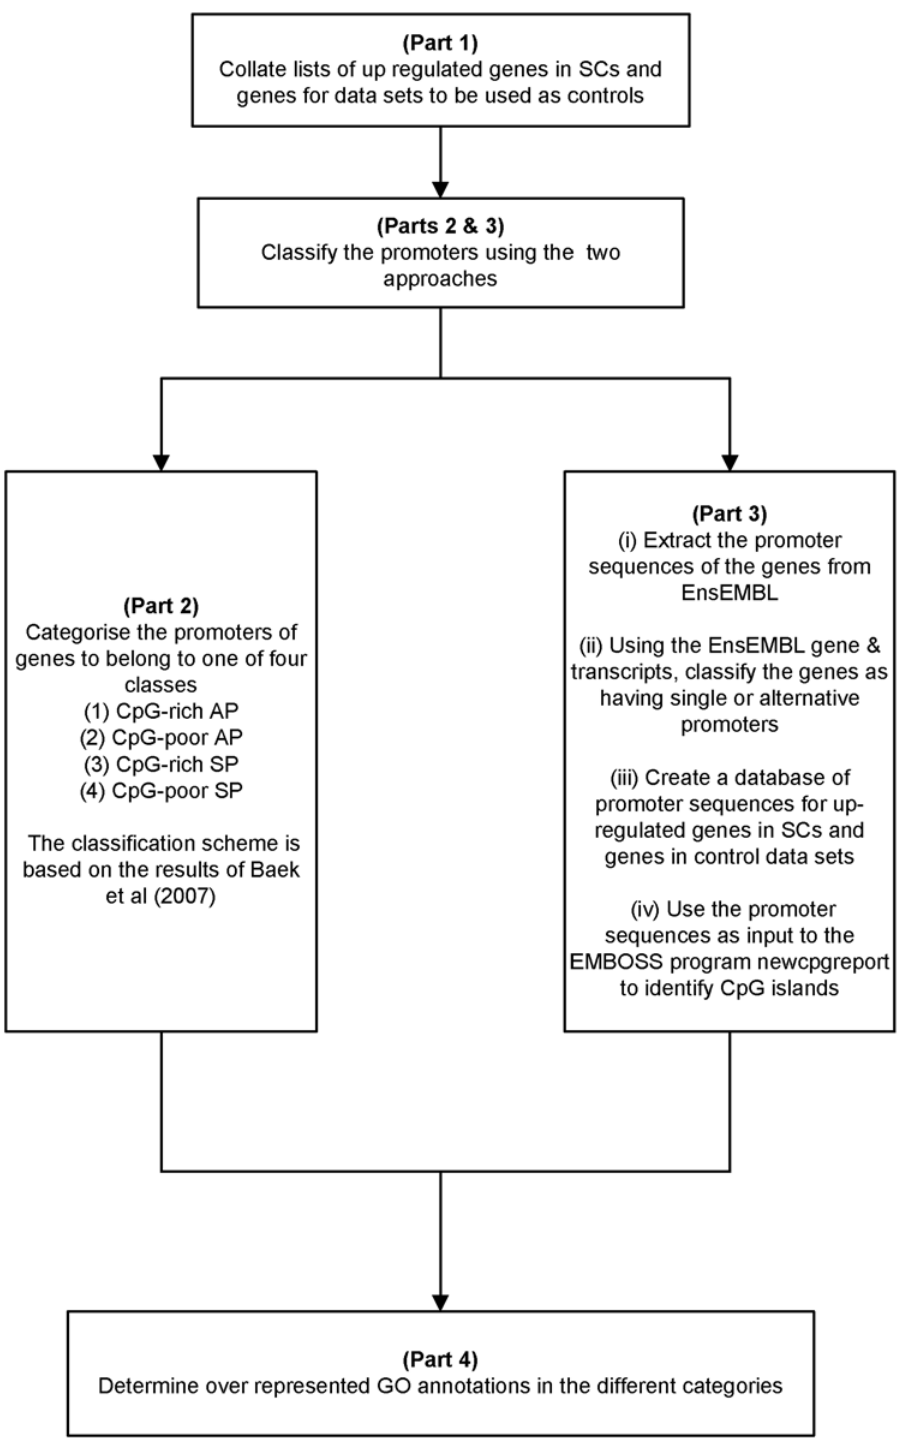
Figure 1. A schematic describing the work flow of the analysis.